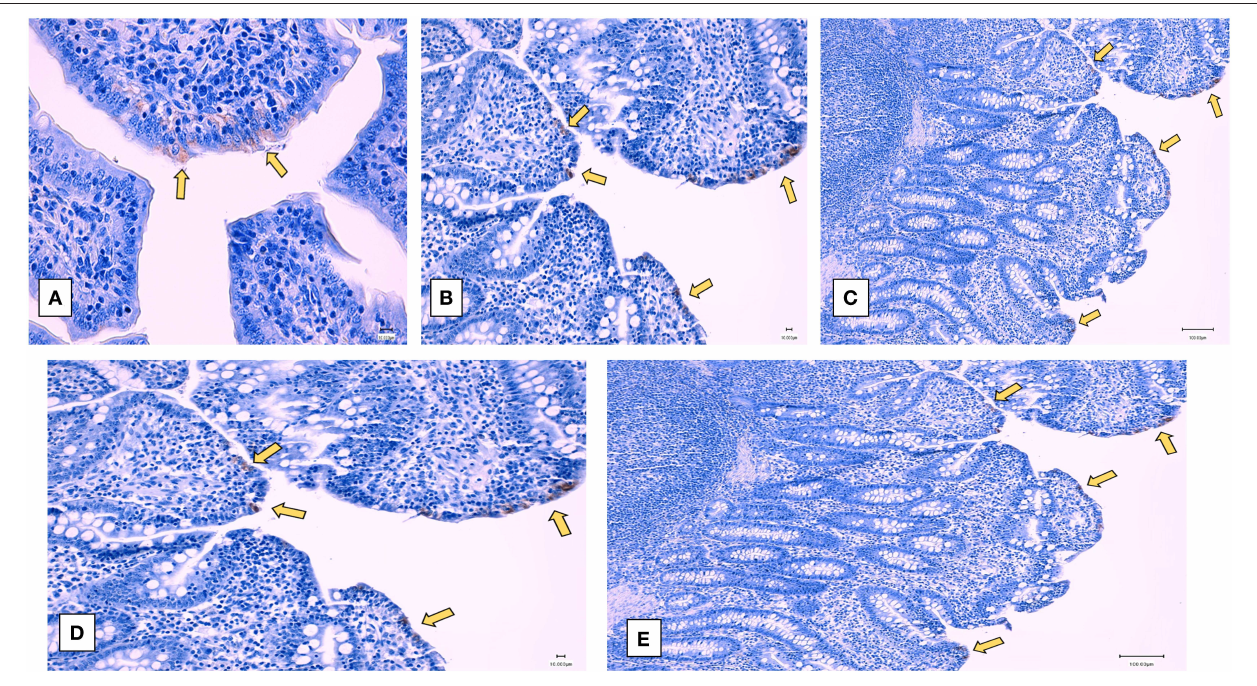
FIGURE 6 | Post-challenge immunohistochemistry of small intestines—Representative immunohistochemistry images of sections stained by a PEDV-specific antibody. (A–C) unvaccinated challenged pigs. (A) Jejunum (400X), (B) ileum (200X), (C) Duodenum (100X), (D,E) Pigs vaccinated with the irradiated vaccine and challenged (D) ileum (200X) (E) Duodenum (100X). Yellow arrows indicate viral antigen localized to enterocytes. Pigs vaccinated with the heat and RNase treated vaccine and challenged did not show microscopic or immunohistochemistry changes (data not